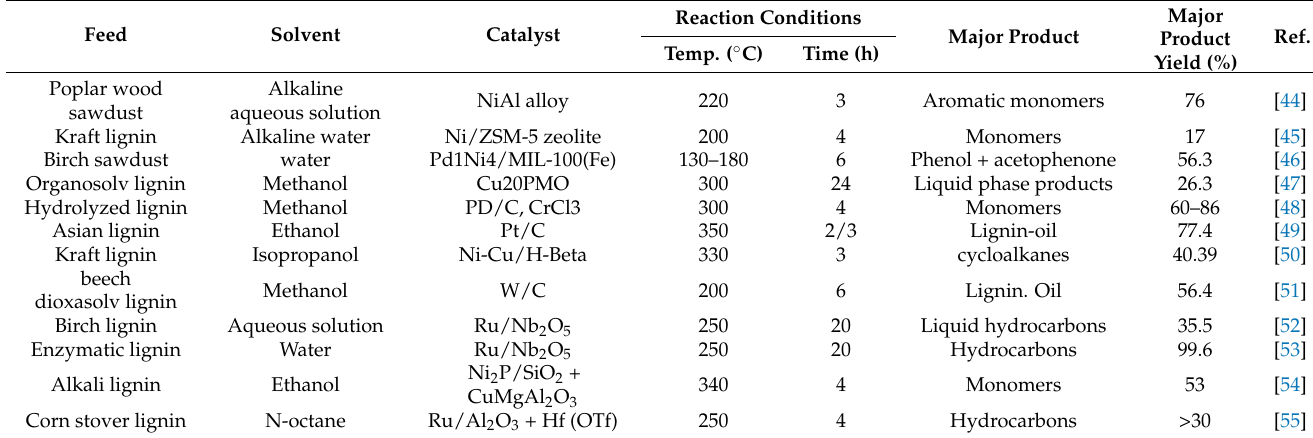
Table 2. Conversion of lignin in different solvents [43].